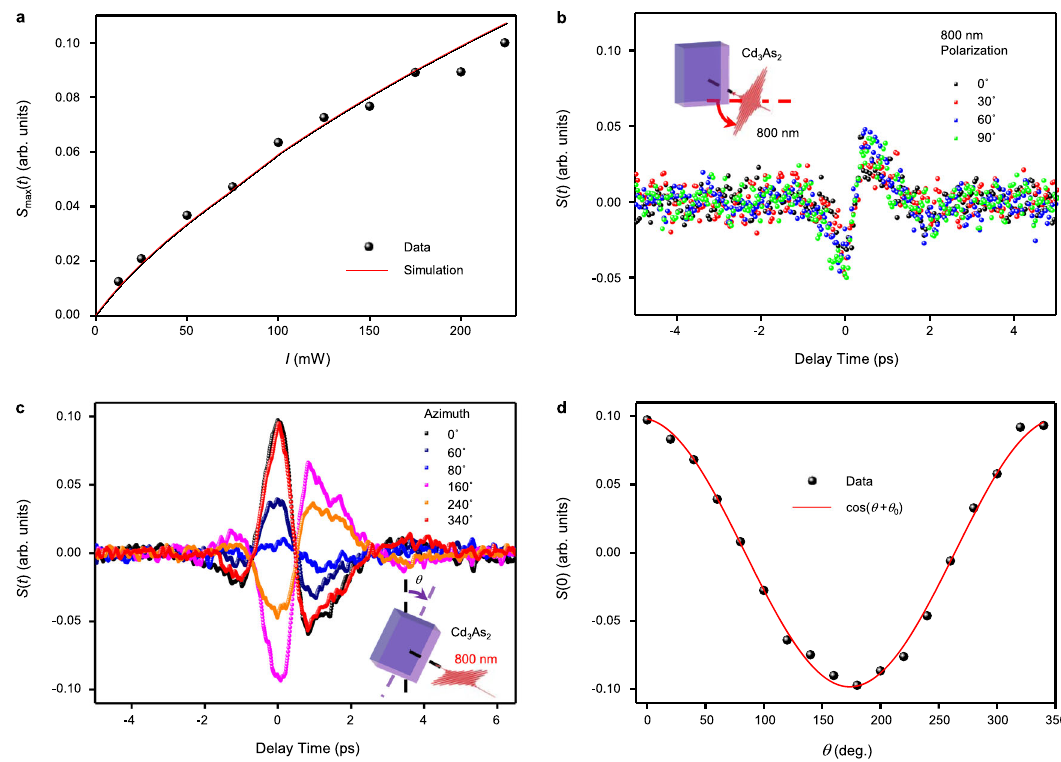
Fig. 2 THz emission from Cd 3 As 2 without applying magnetic fi eld. a The laser intensity dependence of the peak fi eld of emitted THz pulse. The red line is the simulation of power dependence according to the TE response presented in Supplementary Note 5. b Typical THz waveforms excited by laser with different polarized direction. c Typical THz waveforms at different azimuthal angle θ , the thickness gradient is roughly set along y -axis for θ = 0 ° , with unintentional deviation of θ 0 . d The azimuthal angle dependence of the peak fi eld of emitted THz pulse, and the red line is the cosinoidal fi tting cos ( θ + θ 0 ), the deviation ( θ 0 ) is 6.2 ° according to the fi tting. Insets in panels ( b , c ): the schematic illustrations of the corresponding